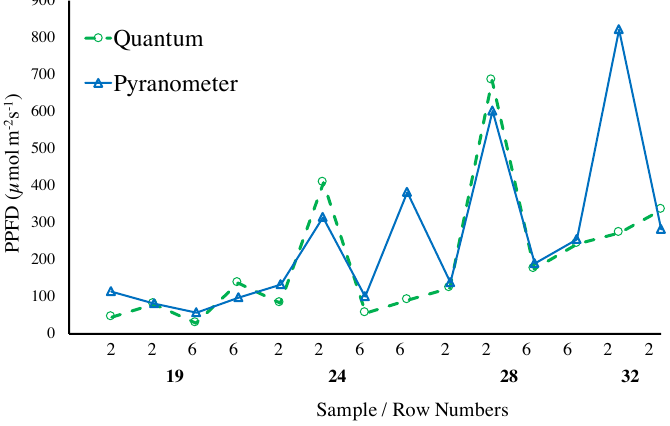
Figure 11. Comparison between the Pyranometer LI-200 SA and the PAR Quantum LI-190 SA. The data is organized over rows of plants, with the horizontal axes showing the number of samples collected per row and the row number from Figure